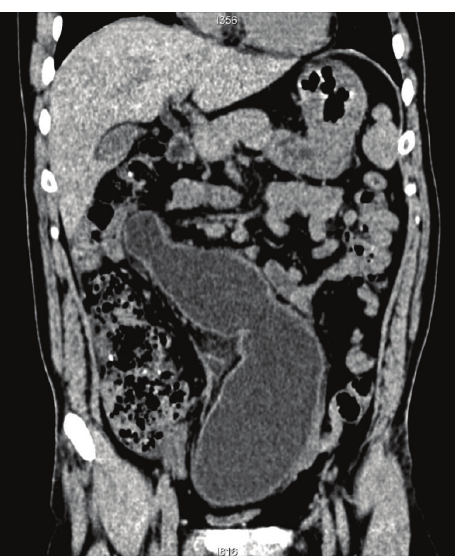
Figure 1: Coronal reconstruction image shows a tortuous tubular cyst with partial obscure wall.